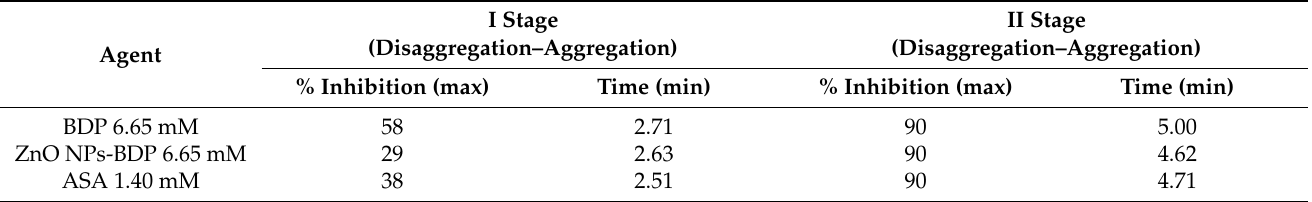
Table 2. The inhibition (%) of platelet aggregation by 6.65 mM of BDP, ZnO NPs-BDP 6.65 mM, and ASA 1.40 mM.